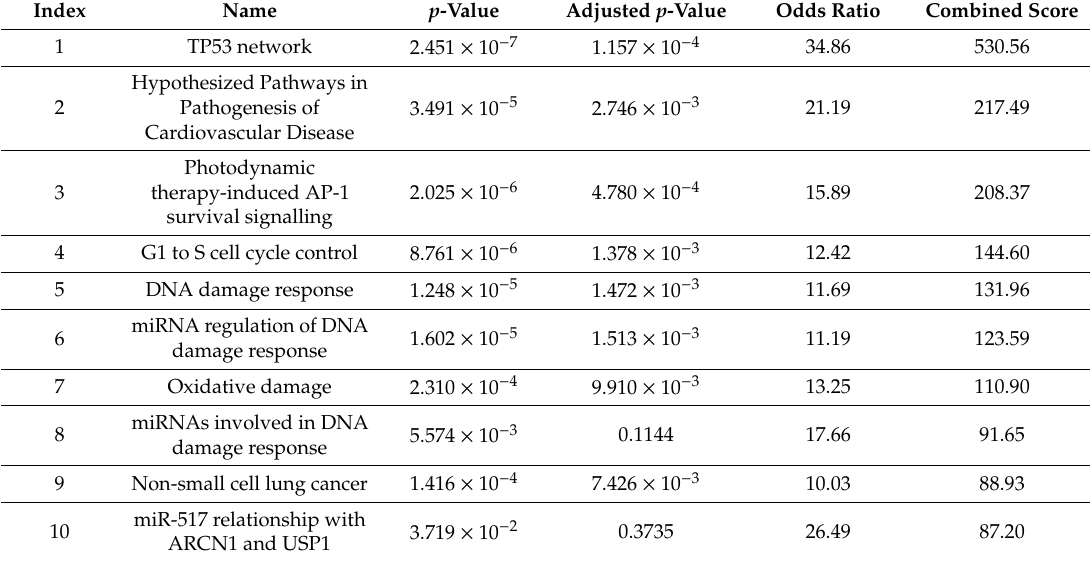
Table 4. Signaling pathways deduced from TAp73 target genes identified in the genome-wide studies. The 153 TAp73 target genes identified and validated in high-throughput studies were used to derive the Gene Ontology (GO) terms, using Enrichr (https: // amp.pharm.mssm.edu / Enrichr /